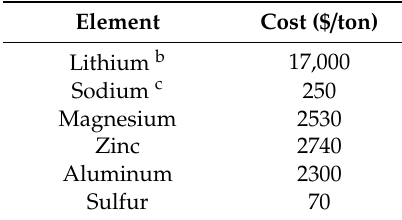
Table 1. The prices of the bulk elements of the di ff erent battery types a . Element Cost ($ / ton) Lithium b 17,000 Sodium